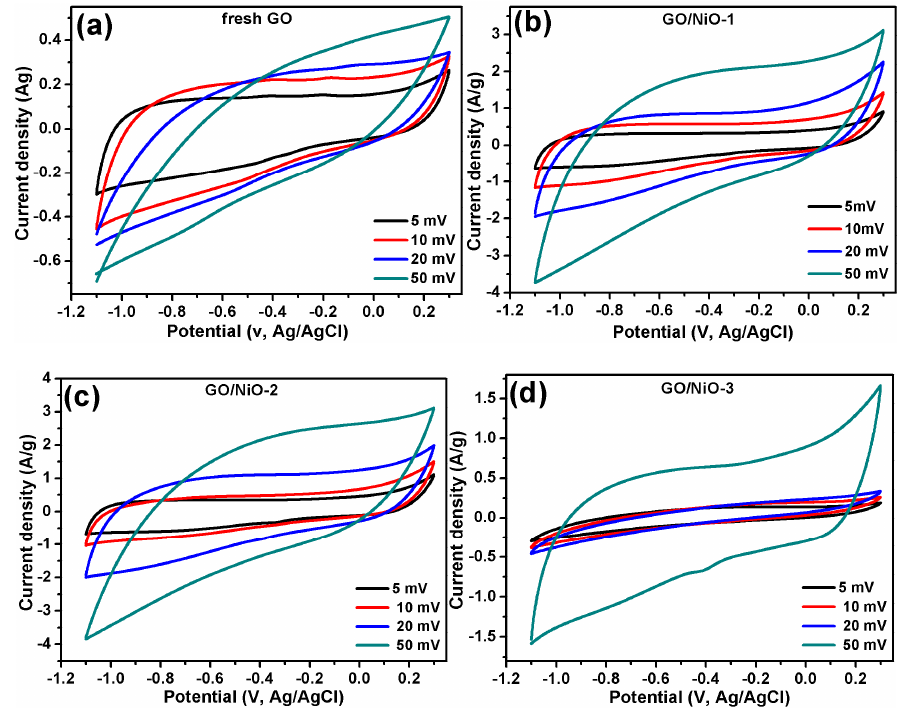
Figure 12. CV curves of ( a ) fresh GO, ( b ) Ni / GO-1, ( c ) Ni / GO-2 and ( d ) Ni / GO with 15 wt% of Ni at Figure. 12. CV curves of ( a ) fresh GO, ( b ) Ni/GO-1, ( c ) Ni/GO-2 and ( d ) Ni/GO with 15wt% of Ni at scan rates between 5 and 50 mVs − 1 scan rates between 5 and 50mVs − 1 .